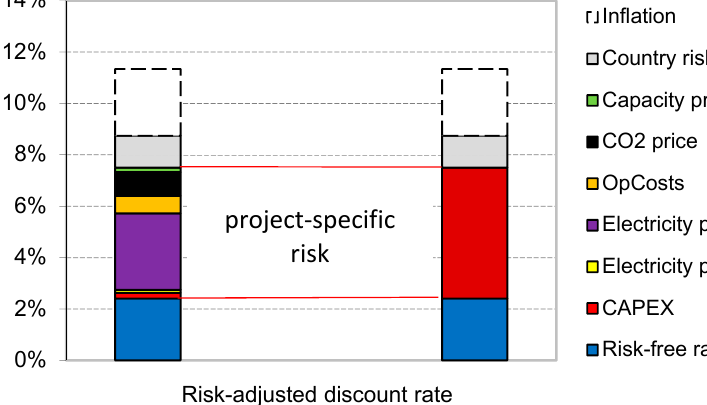
Figure 2. Key risk factors portions of the equity rate of coal-fired power projects under Polish conditions.